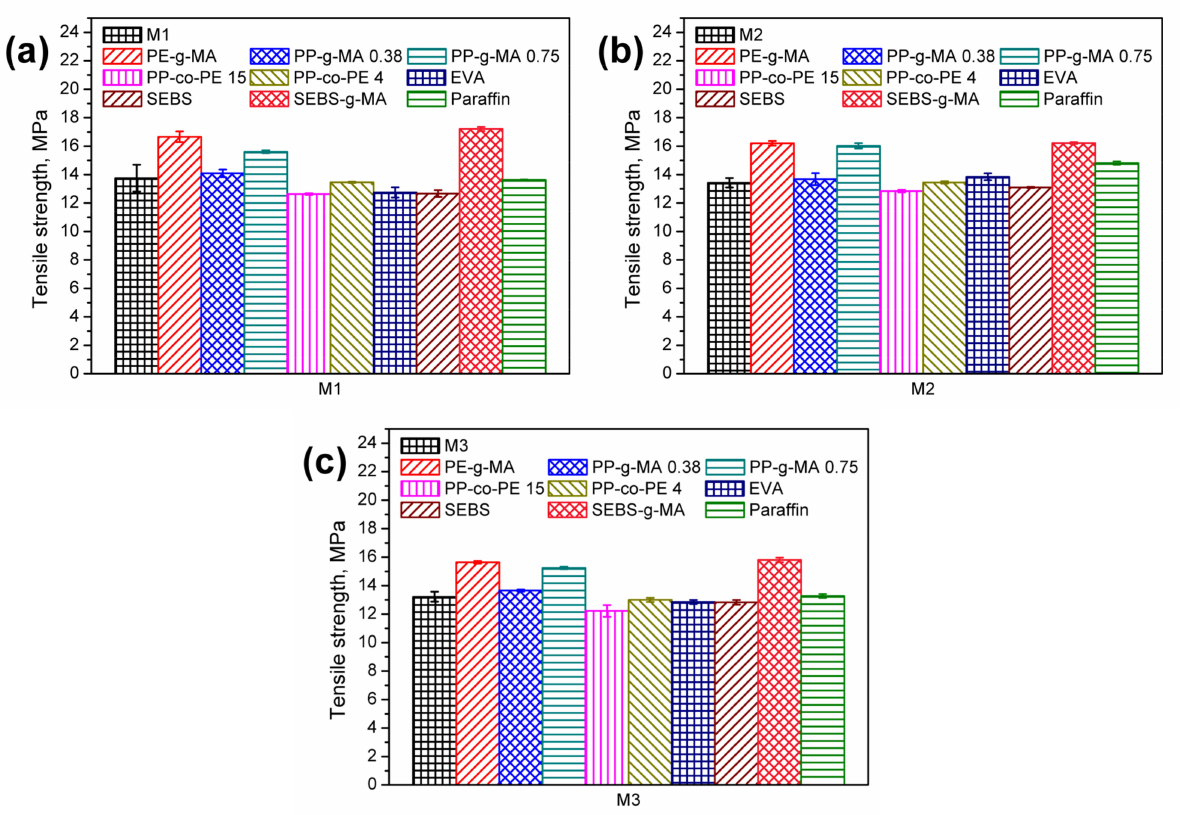
Figure 9. Tensile strength of compatibilized ( a ) M1, ( b ) M2, and ( c ) M3 wastes.